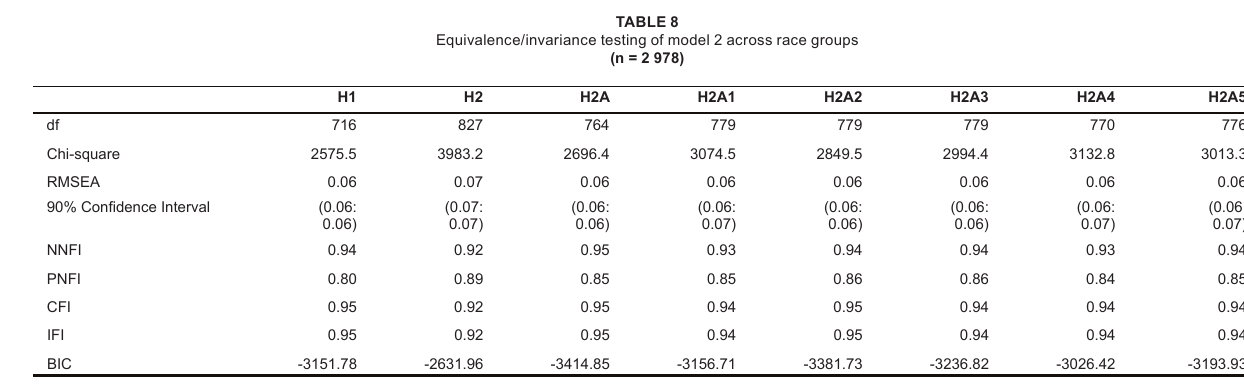
TABLE 8 Equivalence/invariance testing of model 2 across race groups (n = 2 978)